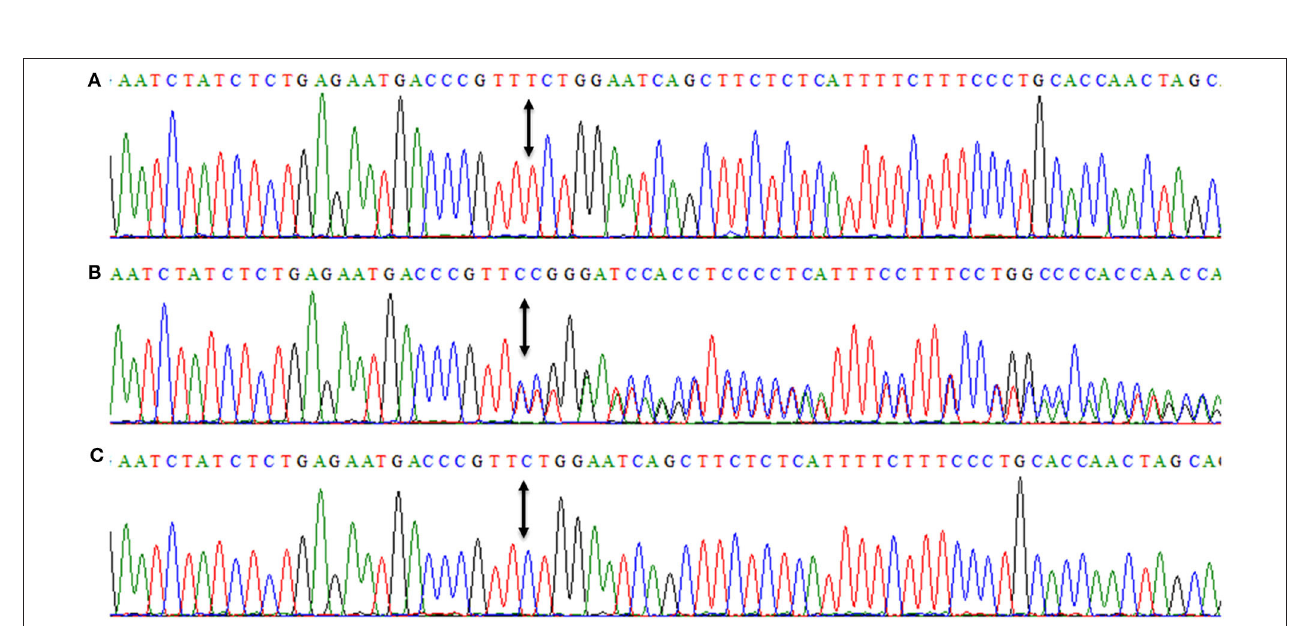
FIGURE 4 | Nucleotide sequence of first coding exon of DYM showing homozygous frameshift variant (c.95_96insT, p.W33Lfs*14) in an affected member (IV-7) (A) , while (B) is showing the DNA sequence of a heterozygous carrier (III-4). (C) is showing a DNA sequence of a control individual. Arrows between the sequences are showing the position of the genetic alteration. The above nucleotide sequences are obtained from same forward primer (DYM-F: 5 ′ -ggtagacaaagcatgatgacttttgaac-3 ′ , melting temperature 64.2 ◦ C), used for the Sanger sequencing reaction.